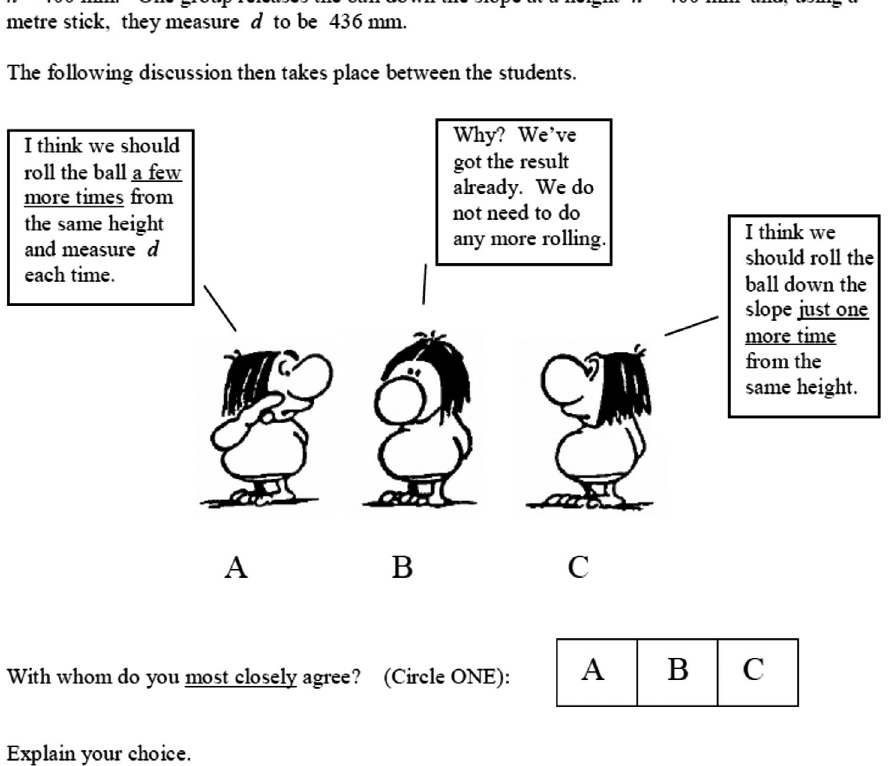
FIG. 1. The RD probe of the PMQ. Reproduced from Ref.